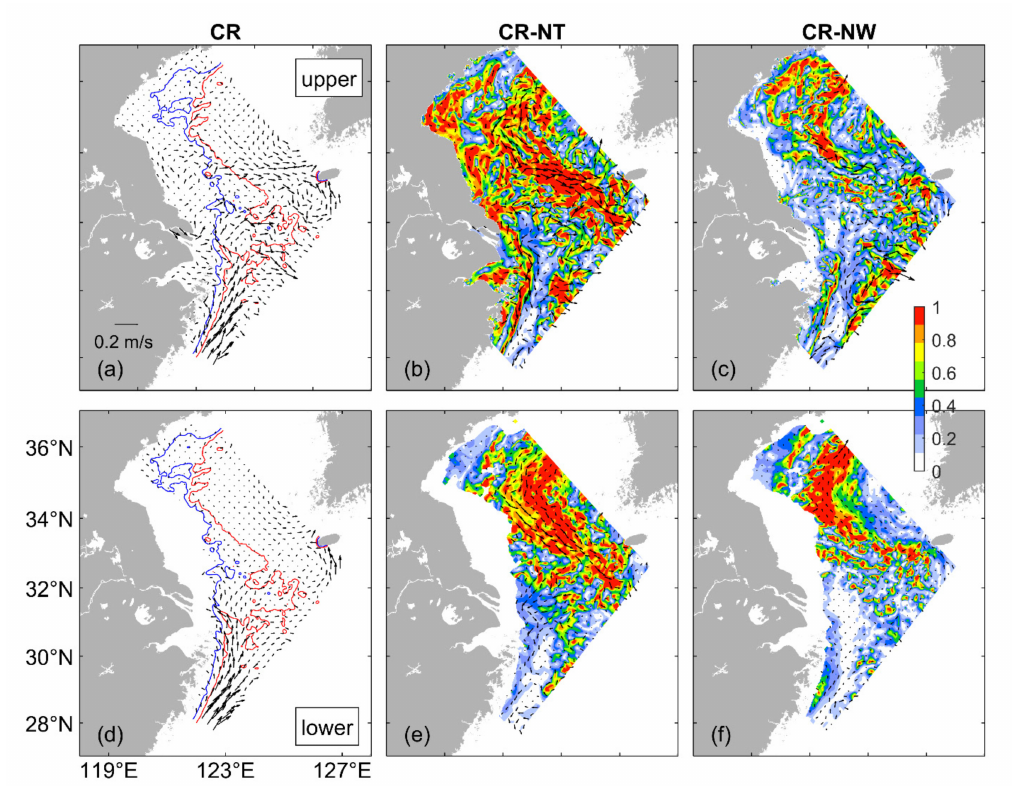
Figure 10. Distribution of monthly mean currents averaged in ( a ) the upper layer from the sea surface to 25 m and ( d ) the lower layer from 25 m to sea bottom in February 2015 calculated from the inner model results in the case of CR. The blue and red contours in ( a , d ) are isobaths of 30 m and 50 m, respectively. Distribution of impact index ( P i , color image) and current differences (arrows) in ( b , c ) the upper layer and ( e , f ) the lower layer ( b , e ) between cases CR and NT and ( c , f ) between cases CR and NW. Vectors are plotted at every 9th grid